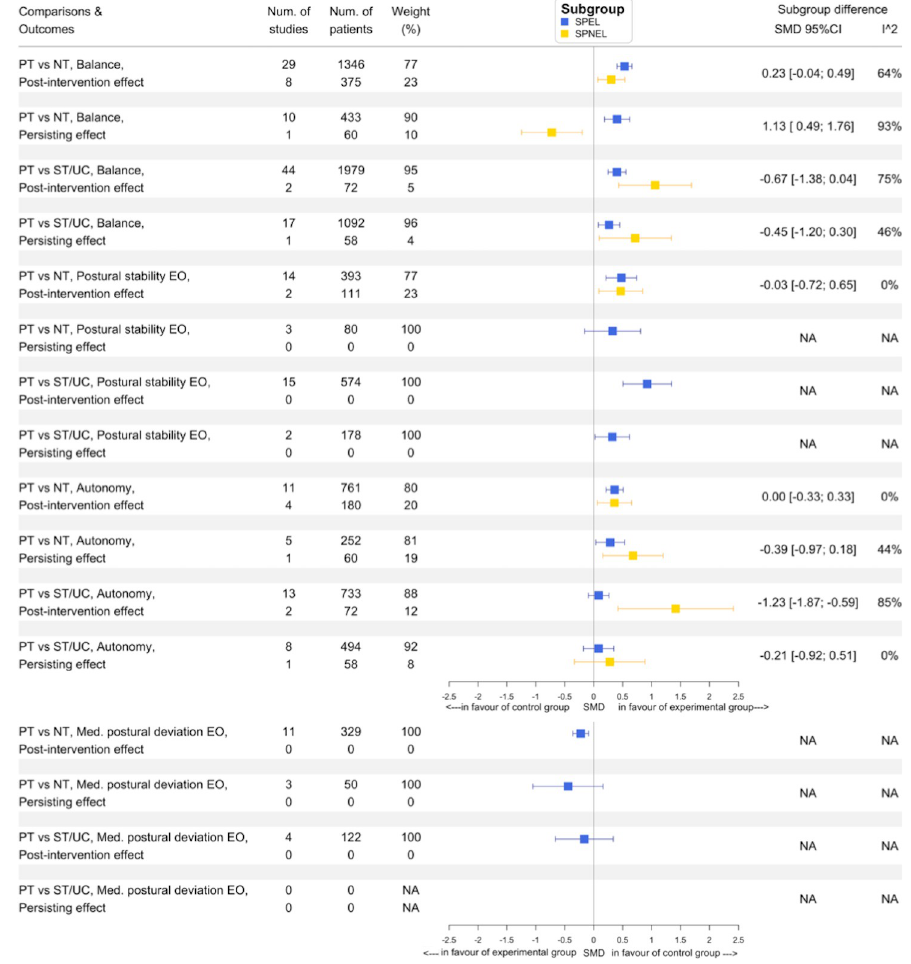
Fig 4. Summary forest plot of subgroup analyses for all outcomes according the language of study publication. Weight is expressed in percent. EO, Eyes open; Med, mediolateral; NA, not applicable; Num, number; NT, no treatment; PT, physical therapy; SPEL, studies published in English language; SPNEL, studies published in non-English language; ST/UC, sham treatment and usual care; vs, versus.